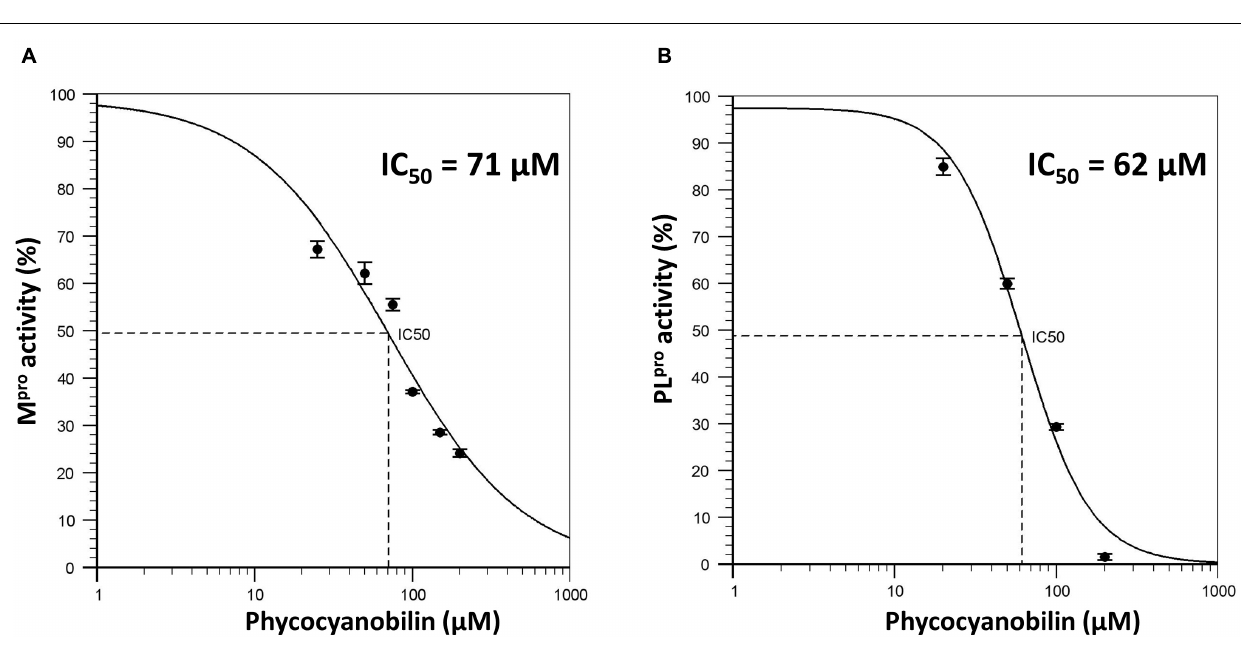
FIGURE 3 | (A) Dose response curve of Phycocyanobilin versus M pro activity; (B) Dose response curve of Phycocyanobilin versus PL pro